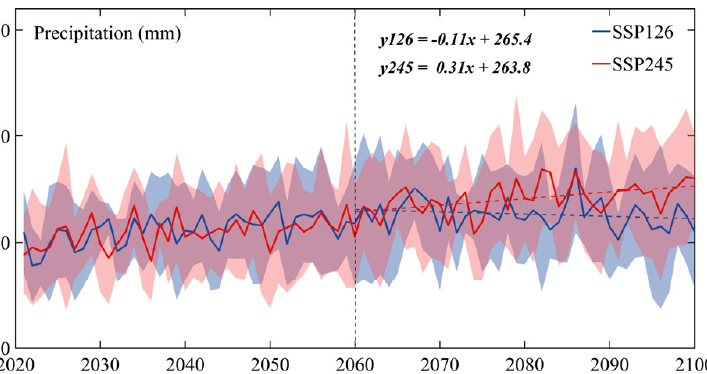
Figure 8. Temporal evolution of precipitation in the drylands of Asia over the two future paths of SSP126 and SSP245. Colored lines represent the mean precipitation ensemble for GCMs 2021–2100 under SSP. Shading represents the range of multiple GCMs. Colored dashed lines indicate trend lines to better compare trend changes in precipitation.